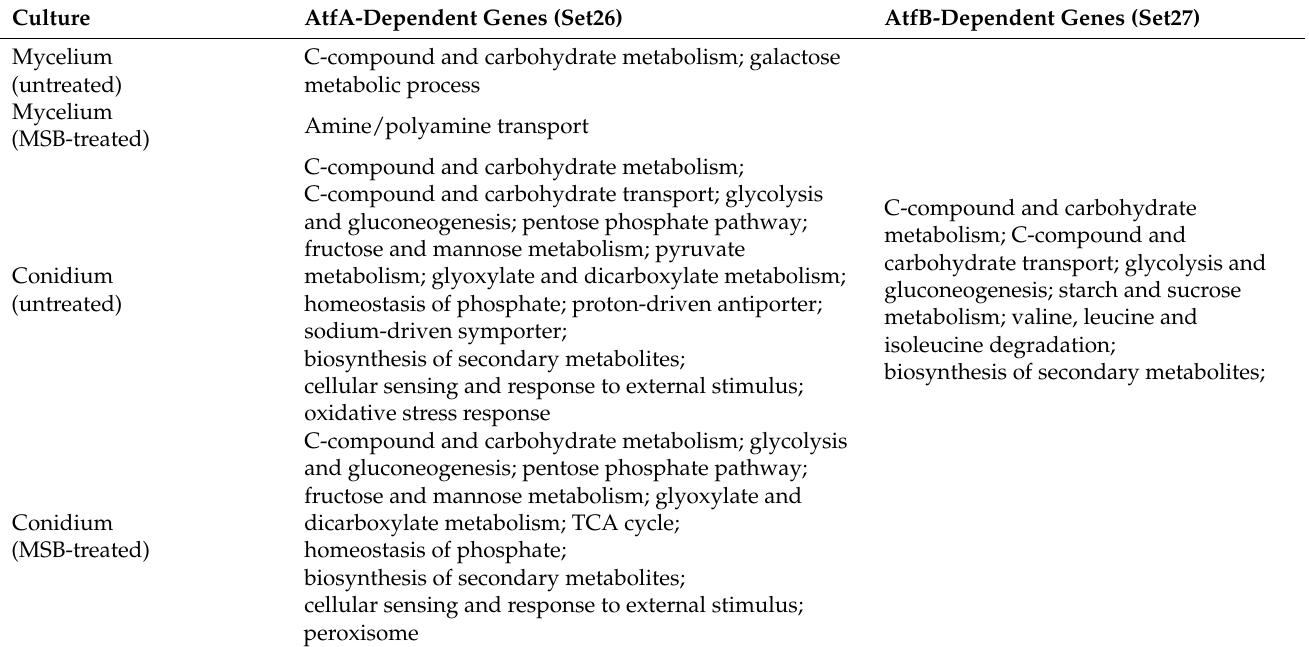
Table 3. Selected significantly enriched FunCat, GO and KEGG pathway term of the AtfA- and AtfB-dependent gene sets. The full list of significantly enriched terms is available in Table S2.